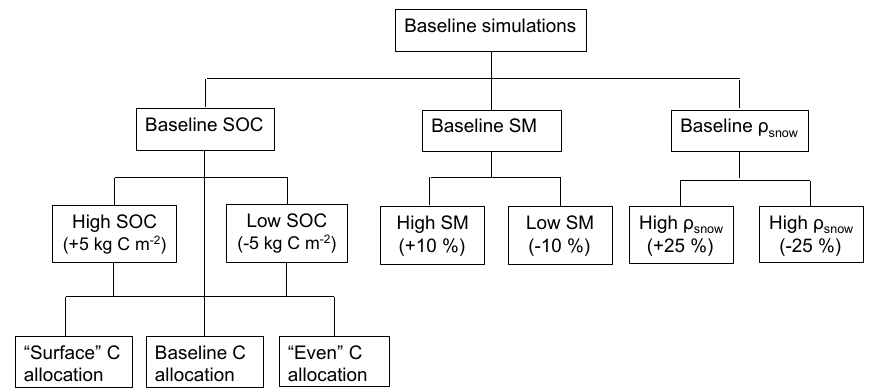
Figure 1. Flow diagram describing the regional model sensitivity runs, accounting for uncertainties in total SOC content, SOC vertical distribution, SM, and snow density ( ρ snow ). Three SOC vertical allocation schemes were represented, including “surface”, baseline, and “even” allocation scenarios (Table